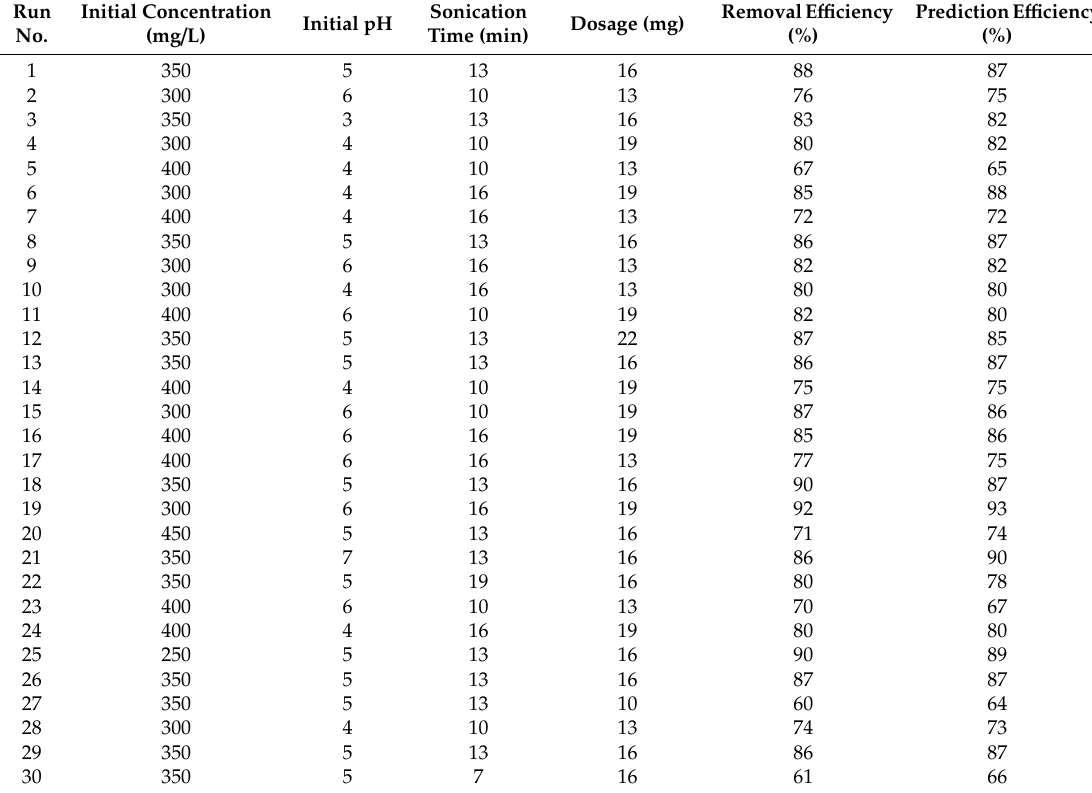
Table 2. Central composite design matrix for ethyl violet (EV)